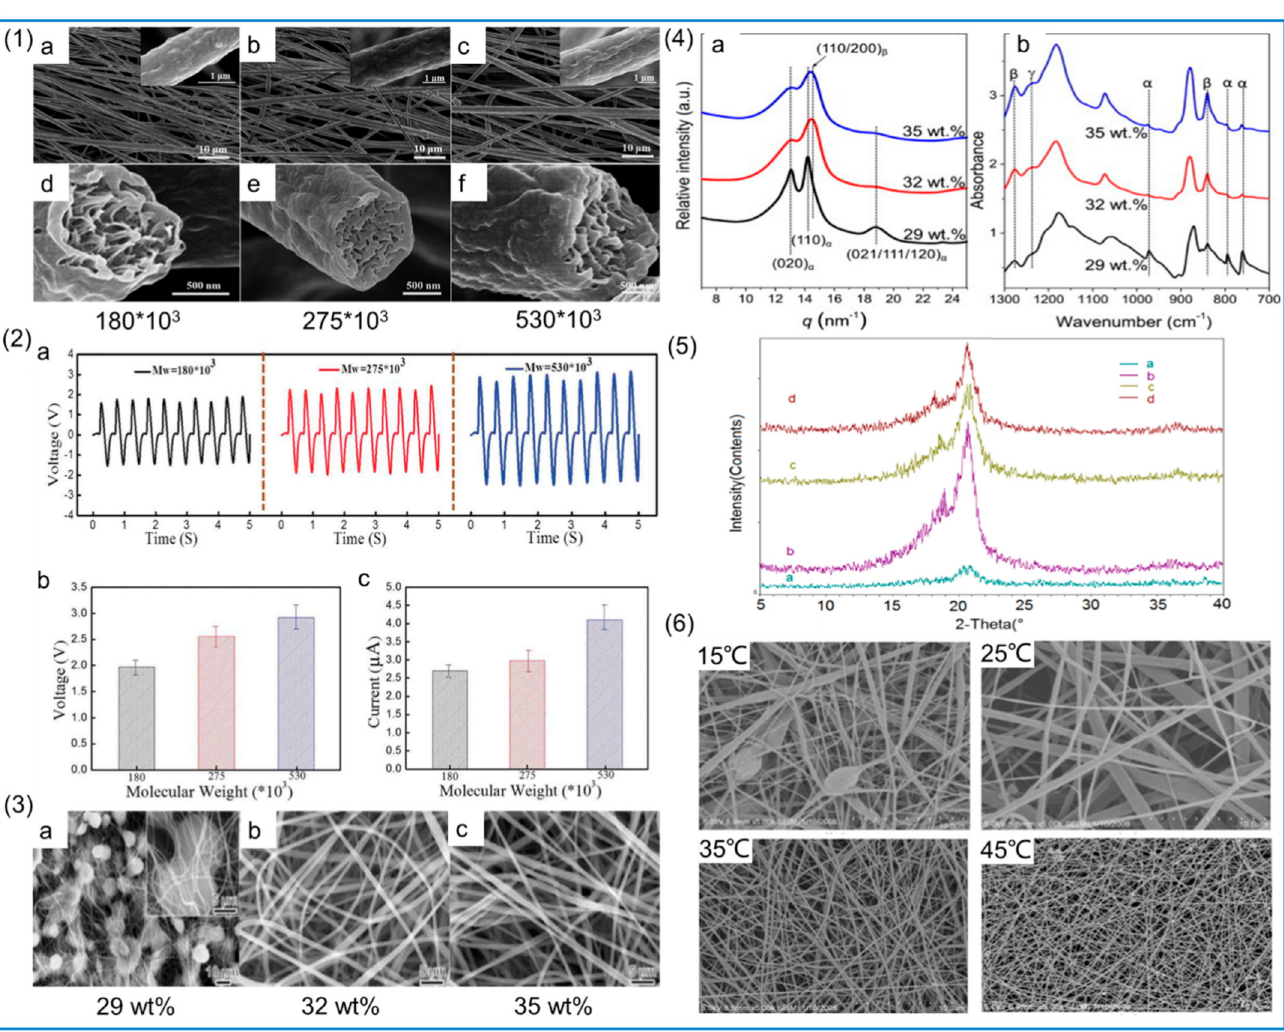
Figure 5. ( 1 ) SEM images of electrospun PVDF NFs with different molecular weights